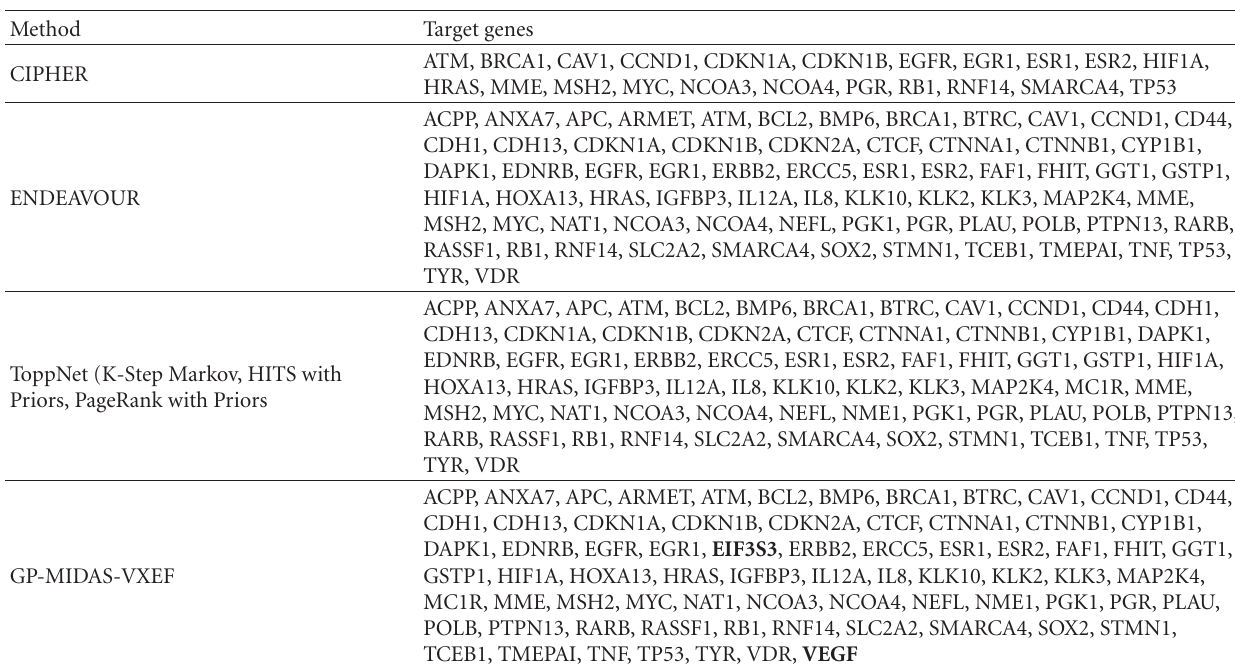
Table 2: Target genes found across